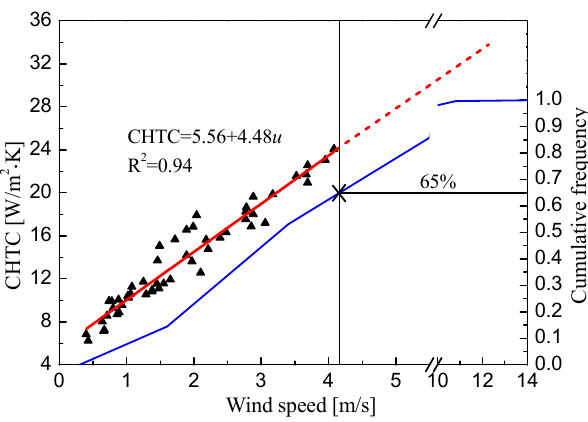
Figure 6. Relationship between convective heat transfer coefficient (CHTC) and wind speed.